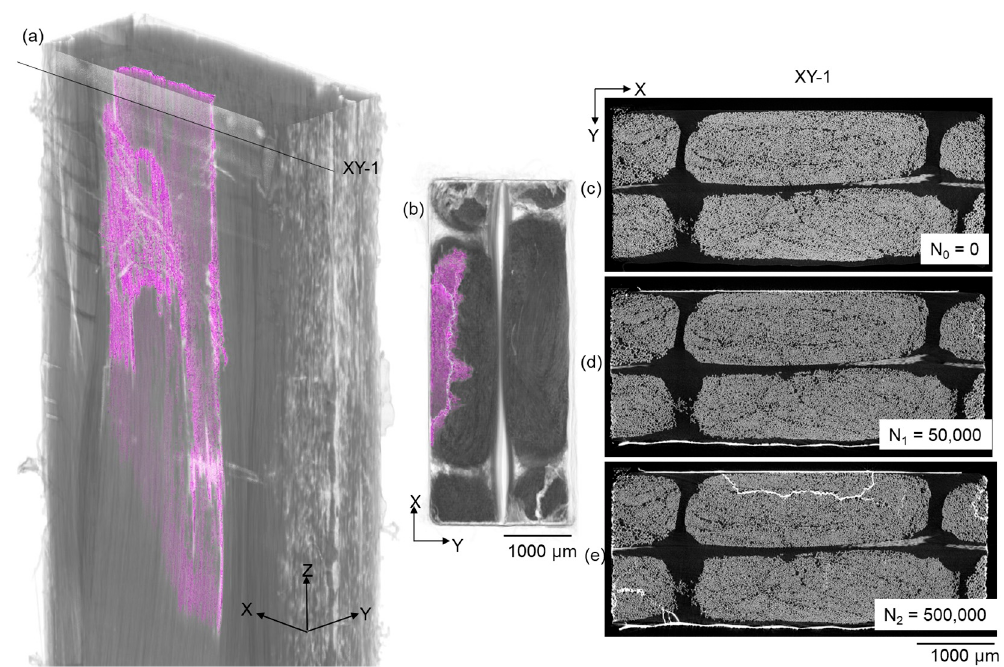
Figure 9. ( a ) Perspective and ( b ) plan view of the X-ray CT 3D volume rendering showing the extent of longitudinal splitting (purple), and an X-ray CT virtual XY section (position indicated in ( a )) after ( c ) 0, ( d ) 50,000 and ( e ) 500,000 cycles showing the evolution of longitudinal splits.